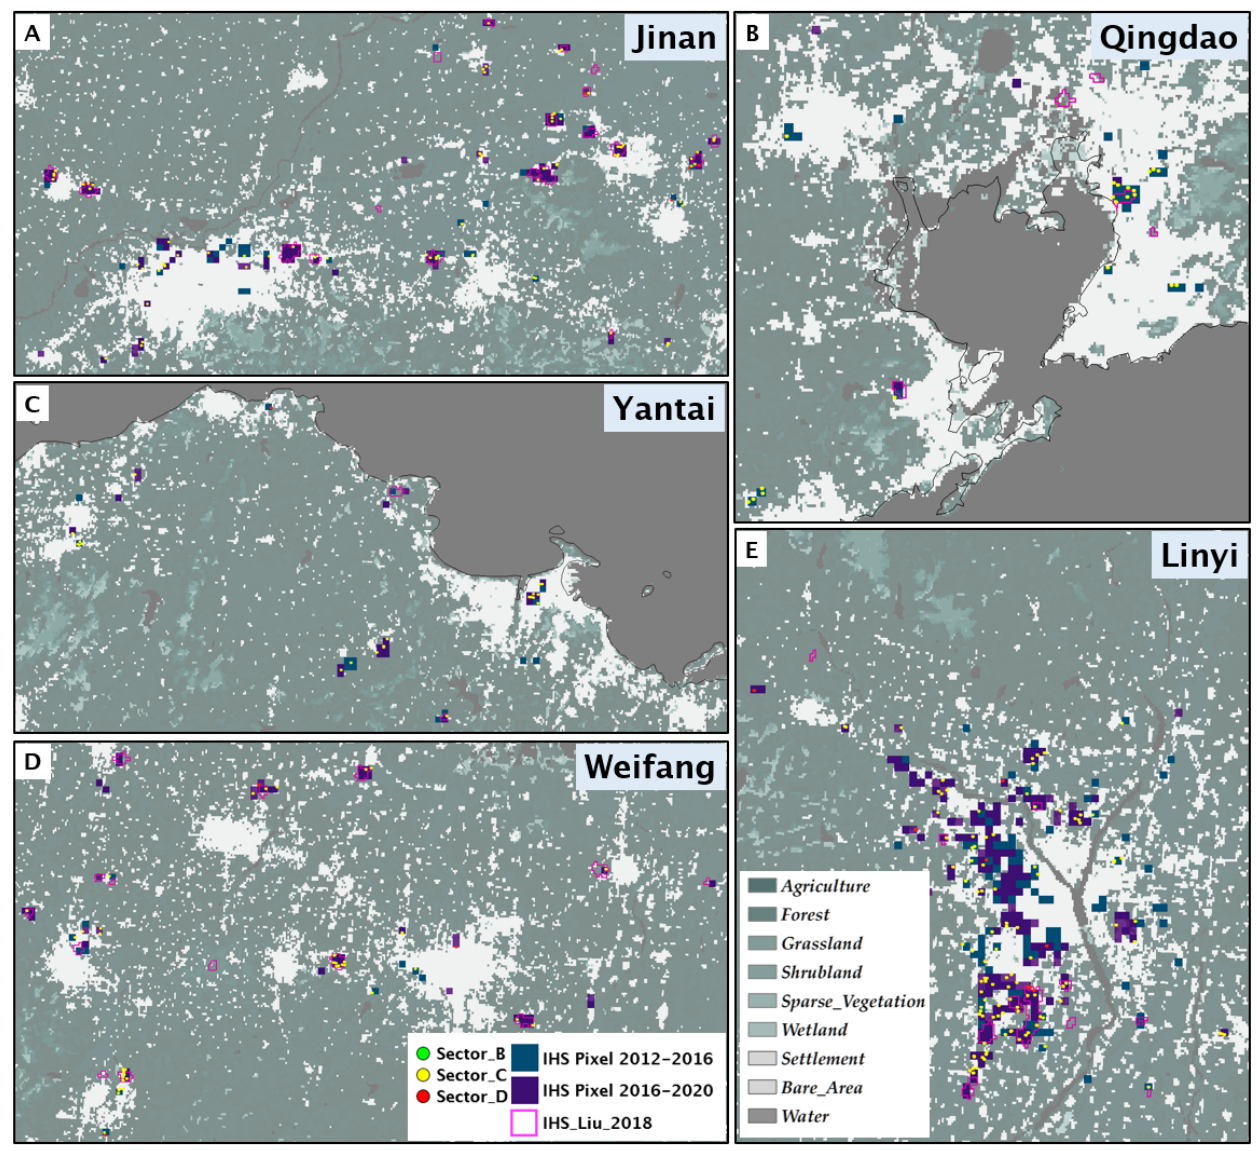
Figure 9. Spatial distributions of industrial heat source (IHS) pixels in the cities with the top 5 highest GDPs in Shandong Province (i.e., Jinan ( A ), Qingdao ( B ), Yantai ( C ), Weifang ( D ) and Linyi ( E )).